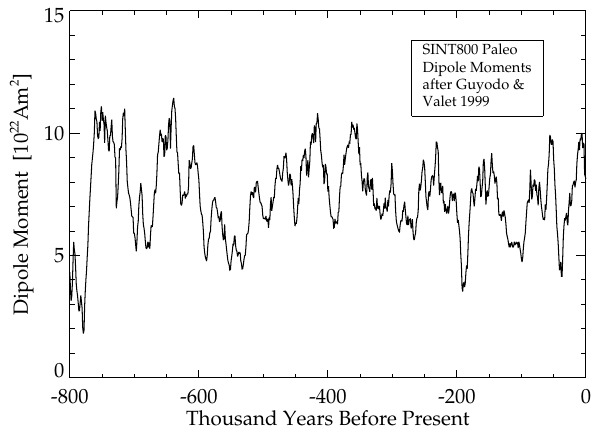
Fig. 1. Dipole moments of the geomagnetic field over the past 800000 years based on relative paleointensities of SINT800 (after Guyodo and Valet,